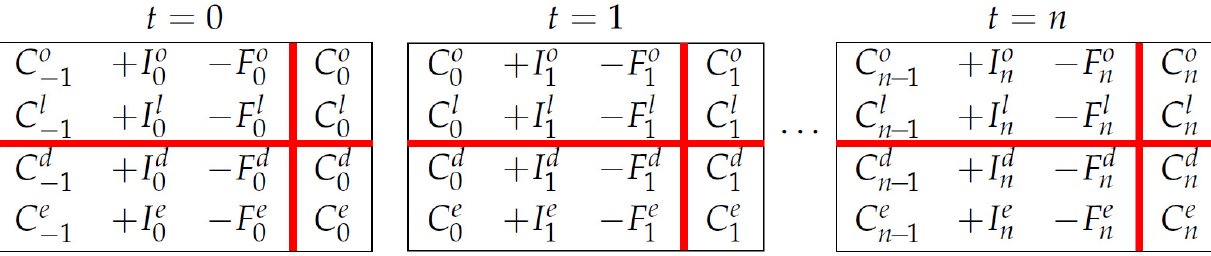
Figure 6. The split-screen film or strip (continuous format) (reprinted from Part I, Equation (67)).